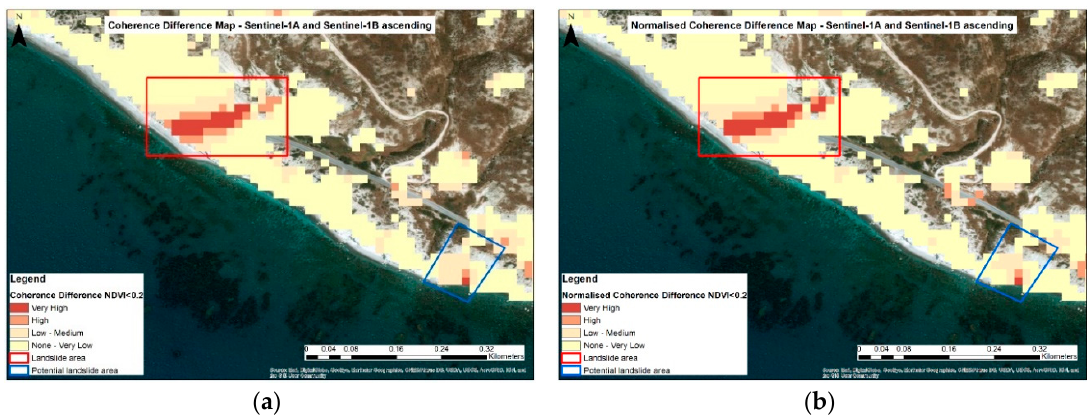
Figure 25. ( a ) Coherence difference and ( b ) normalized coherence difference maps – Sentinel 1-A and Sentinel-1B ascending average.